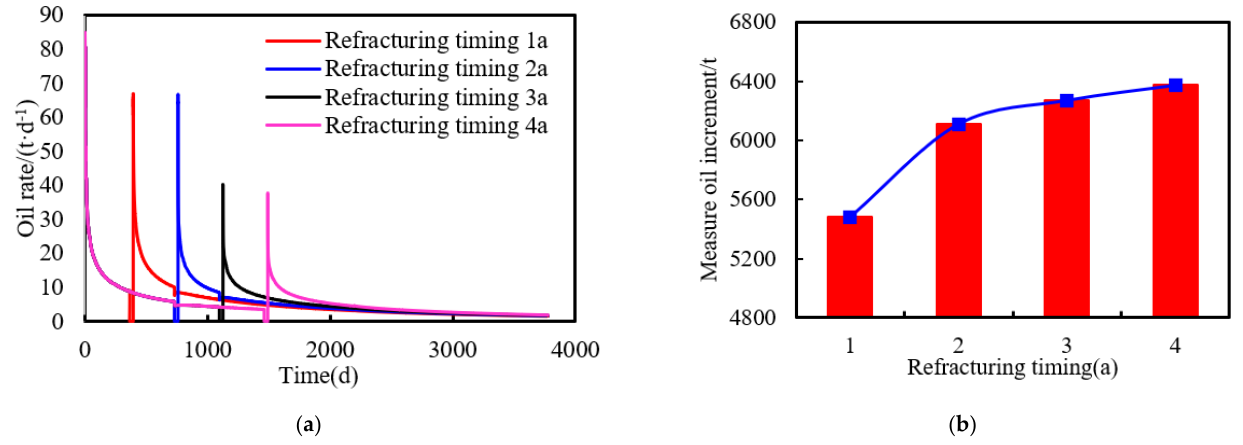
Figure 1. Comparison of production capacity at different refracturing timings: ( a ) Daily production curve at different refracturing times; ( b ) Oil increments at different refracturing times.